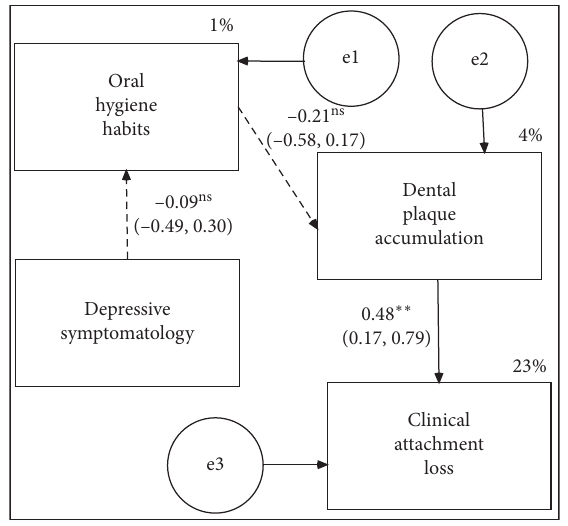
Figure 3: Maximum-likelihood parameter point estimates and 95% Monte Carlo confidence intervals (with 10,000 bootstrap samples) in the mental health sample of 26 patients with depressive symptomatology.